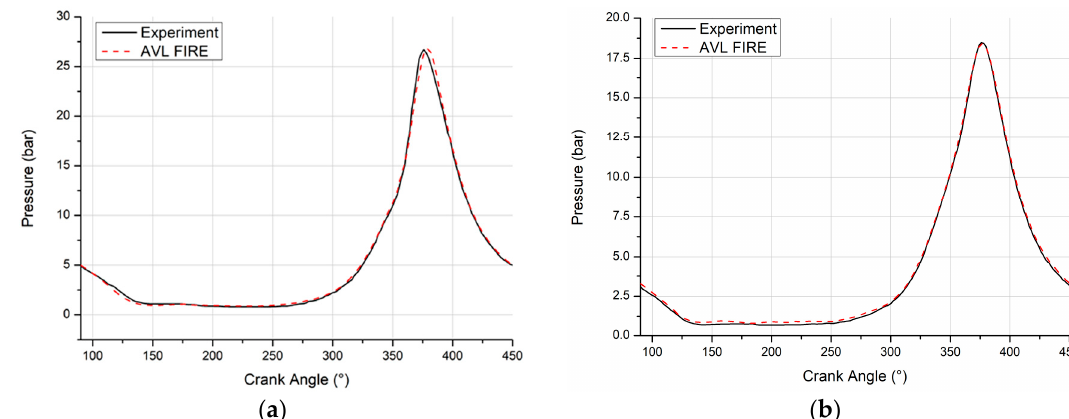
Figure 8. Comparison of in-cylinder pressure curves between the experiment and AVL FIRE simulation. ( a ) High load operating condition; ( b ) partial load operating condition.